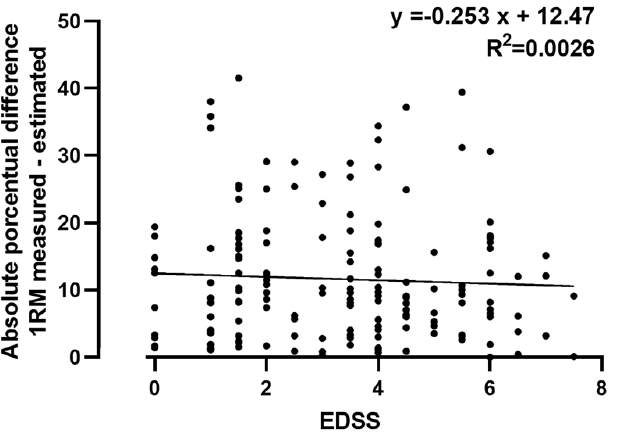
Figure 2. Correlation EDSS and absolute percentage difference in 1RM estimation.